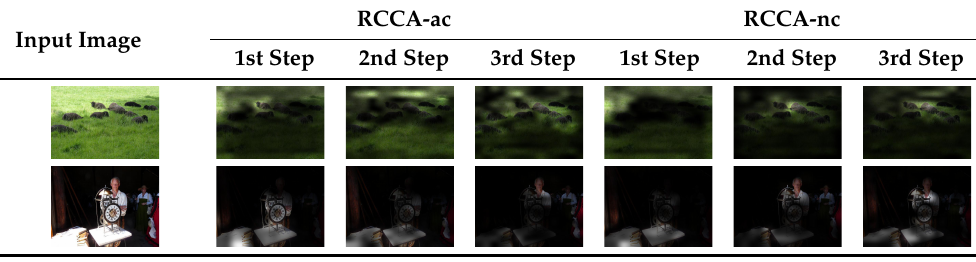
Table 5. Visualization of dynamical attention maps on the Microsoft COCO dataset.